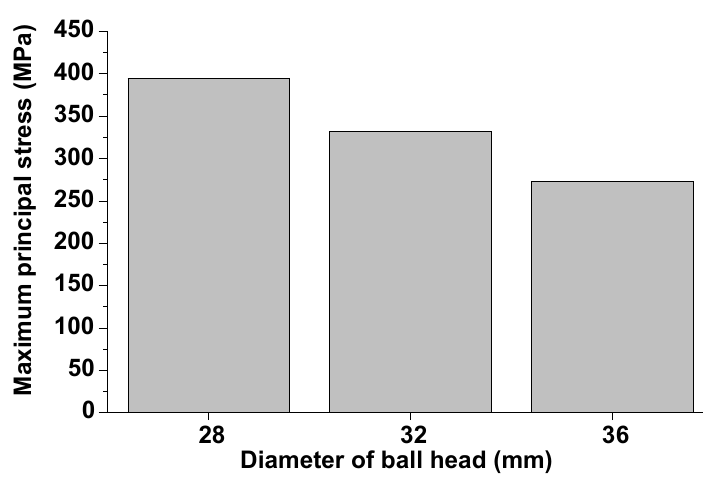
Fig. 5 Maximum principal stress with different sizes of ball head. Increasing the diameter of the ball head reduced the maximum stress value. Maximum principal stress for each ball head: 395 MPa (28 mm), 332 MPa (32 mm), and 273 MPa (36 mm).